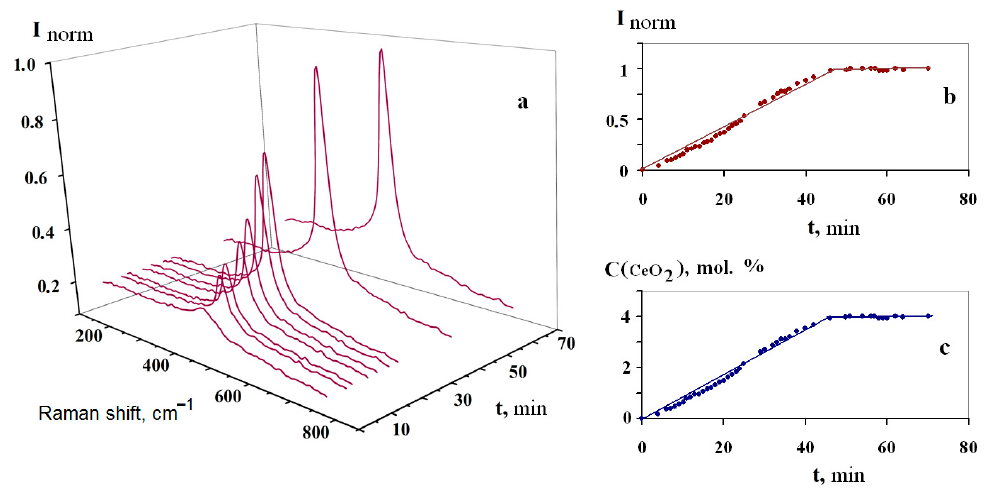
Figure 7. ( a ) Raman spectra of the 0.96FLiNaK–0.04CeF 3 system for various exposure times in the air at 510 °C; ( b ) change in the normalized intensity of the vibrational band at 460 cm − 1 ; ( c ) change in CeO 2 concentration with time.